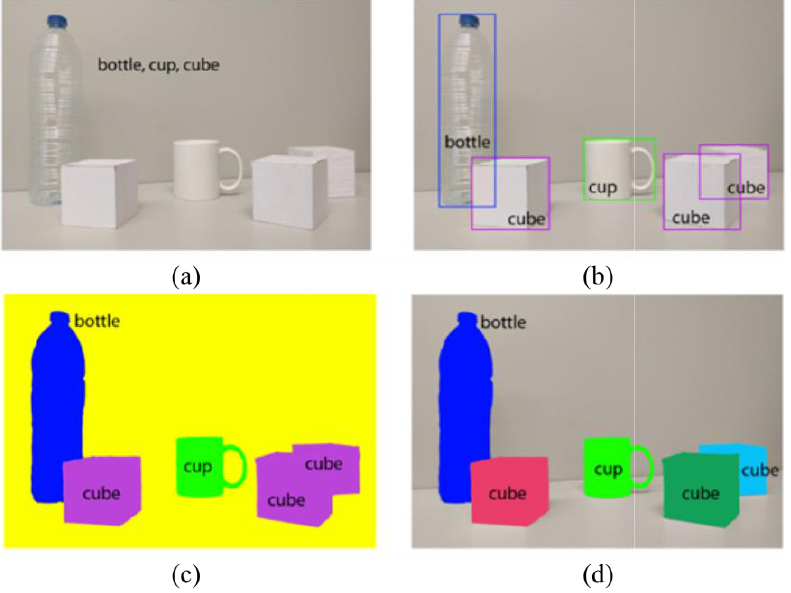
Figure 21. An example of different visual perception problems: ( a ) image classification, ( b ) object detection, ( c ) semantic segmentation, and ( d ) instance segmentation [101].